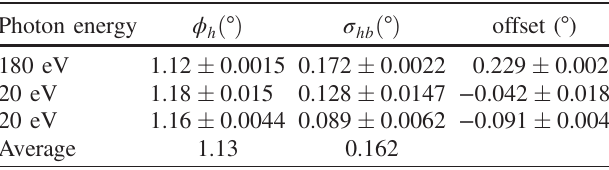
TABLE III. Scan of detector response vs ϕ with no sample, using a 180 eV photon beam. An overall offset from ϕ ¼ 0 , shown in the third column, was also a free parameter in the fit.